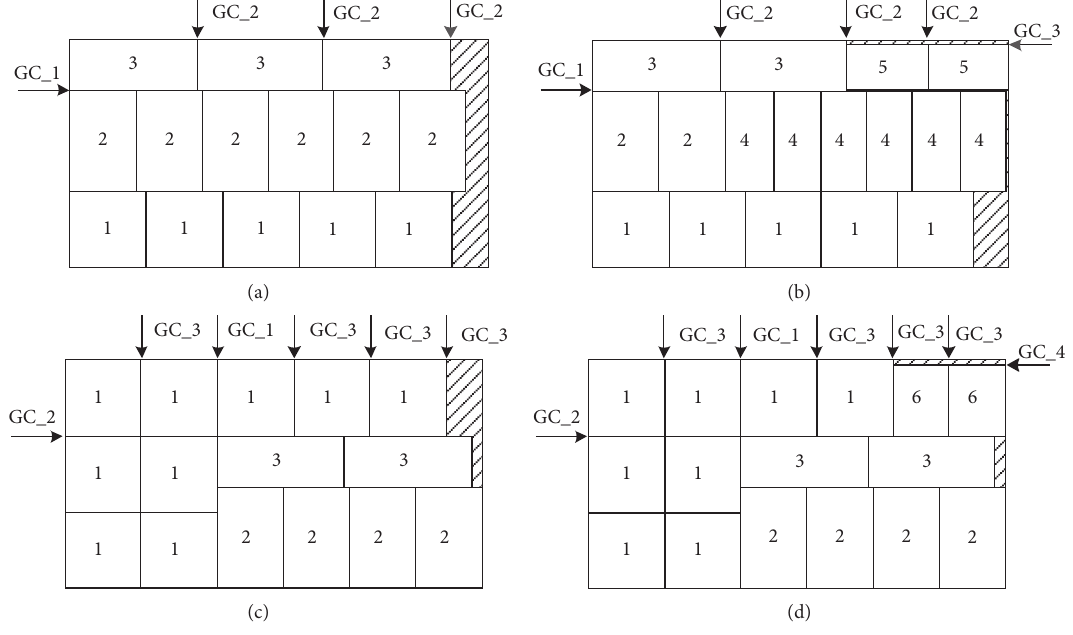
Figure 3: Four common types of staged patterns. (a) 2SHP. (b) 2SGP. (c) 3SHP. (d)